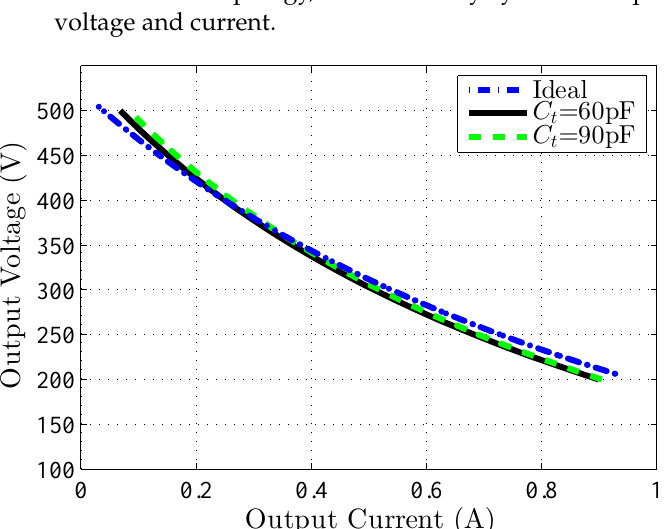
Figure 9. Output voltage to output current curve for EACF using the selected values for parasitic capacitance C t ( d = 0.6582) and ACF ( d = 0.685).